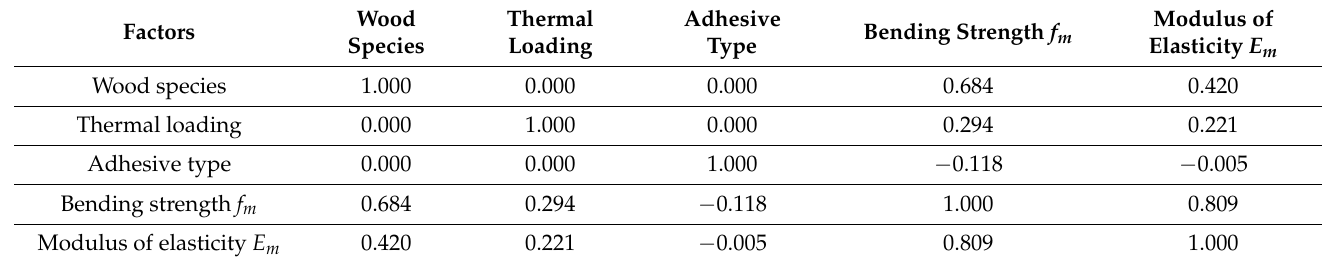
Table 5. Spearman’s correlation between factor groups, bending strength, and modulus of elasticity.